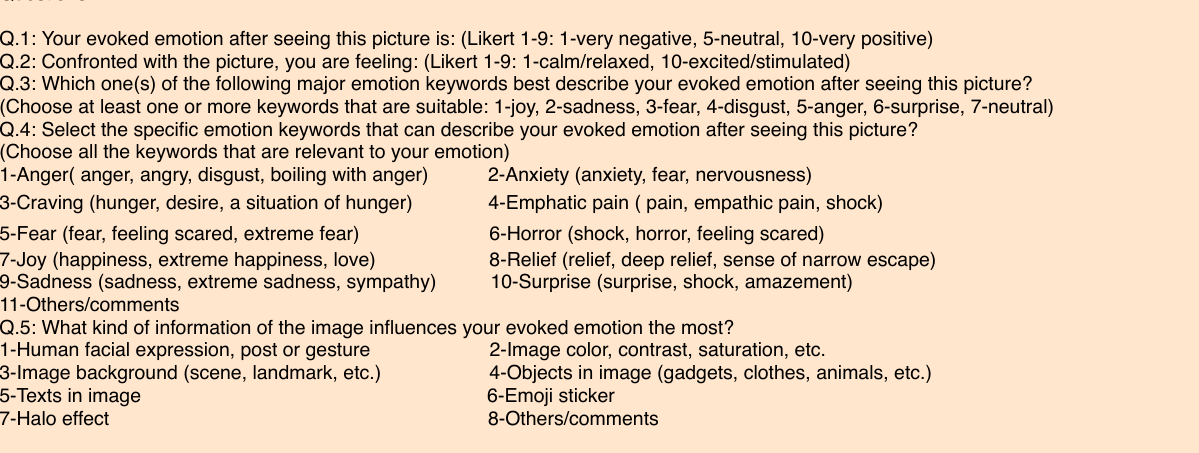
Figure 4. An illustration of the web application used for the crowd-sourcing study. A disaster- related image is provided to the users who are asked to provide options/tags. In case, additional tags/comments can also be